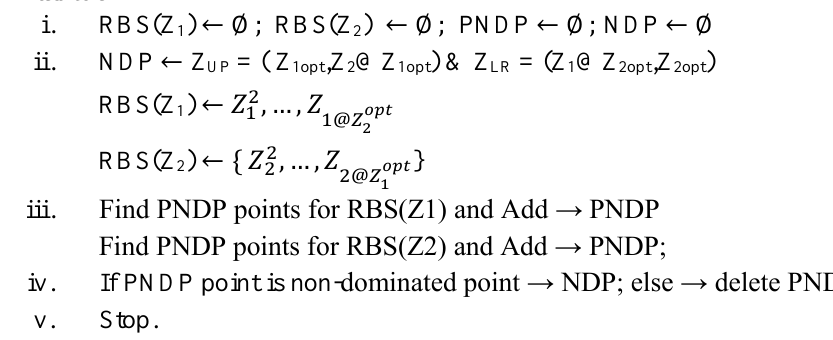
Algorithm 3. ( RBSM Algorithm for MOIP Problem